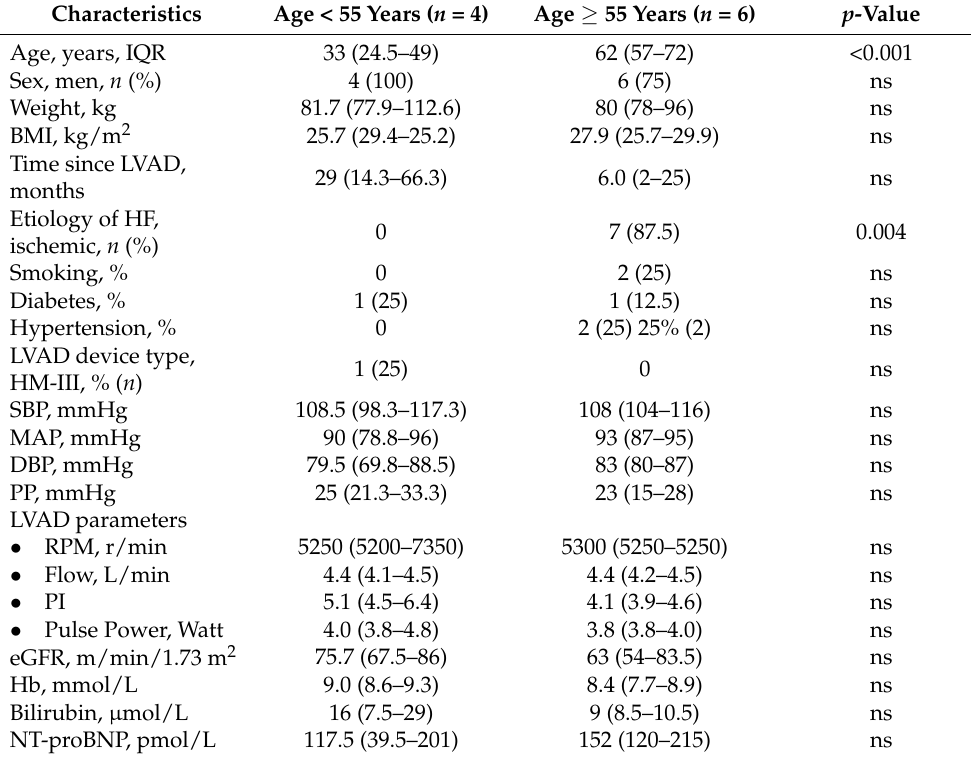
Table 2. Baseline characteristics of HF with an LVAD in different age categories.